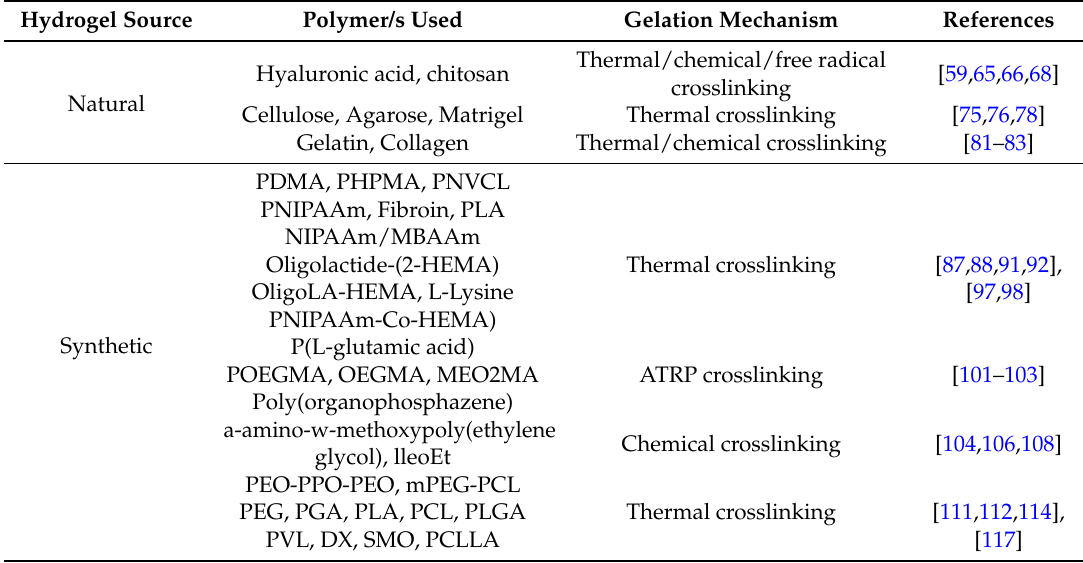
Table 1. Summary of injectable hydrogels for tissue